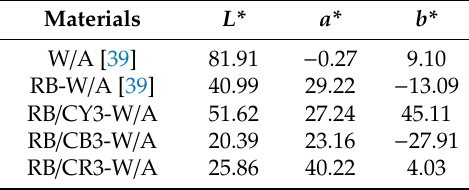
Table 1. CIELab values of pristine W / A, RB-W / A, RB / CY3-W / A, RB / CB3-W / A and RB / CR3-W / A.